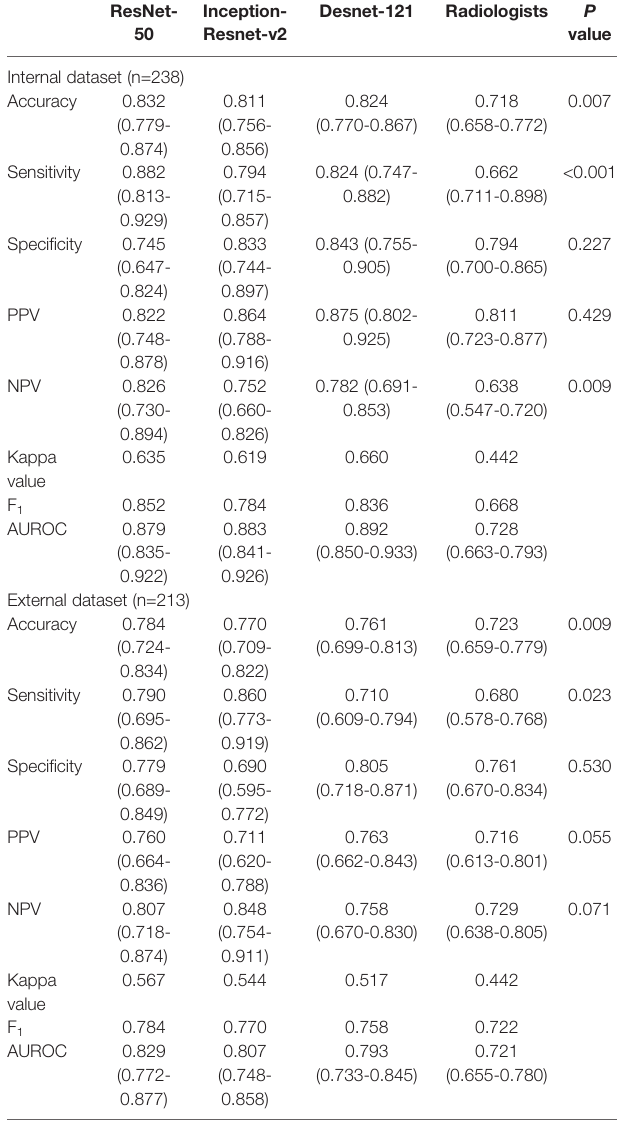
TABLE 5 | Performance of deep learning containing three CNNs compared with the radiologists in differentiating benign and malignant thyroid nodules classi fi ed into ACR TI-RADS category 4 and